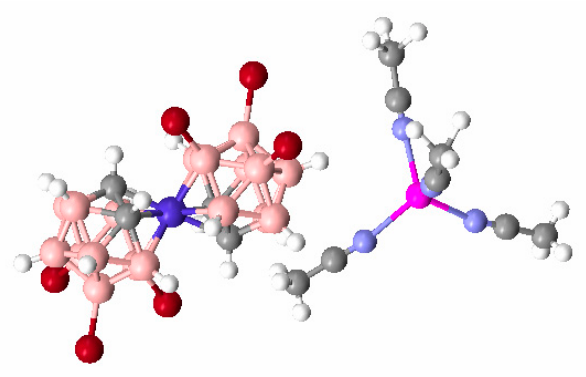
Figure 100. X-ray structure of [(MeCN) 4 Ag][8,8’,9,9’,12,12’-Br 6 -3,3’-Co(1,2-C 2 B 9 H 8 ) 2 ].